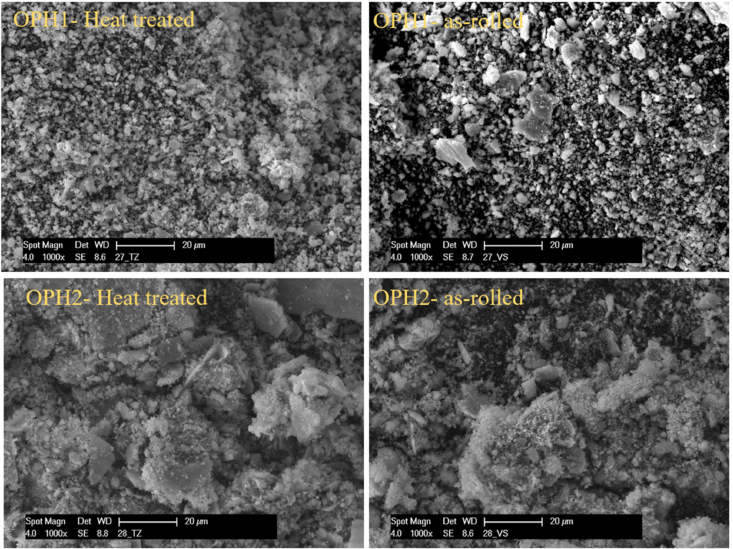
Figure 13. SEM micrographs of wear debris after abrasive wear (after pin-on-disc test) for OPH1 and OPH2 before and after heat